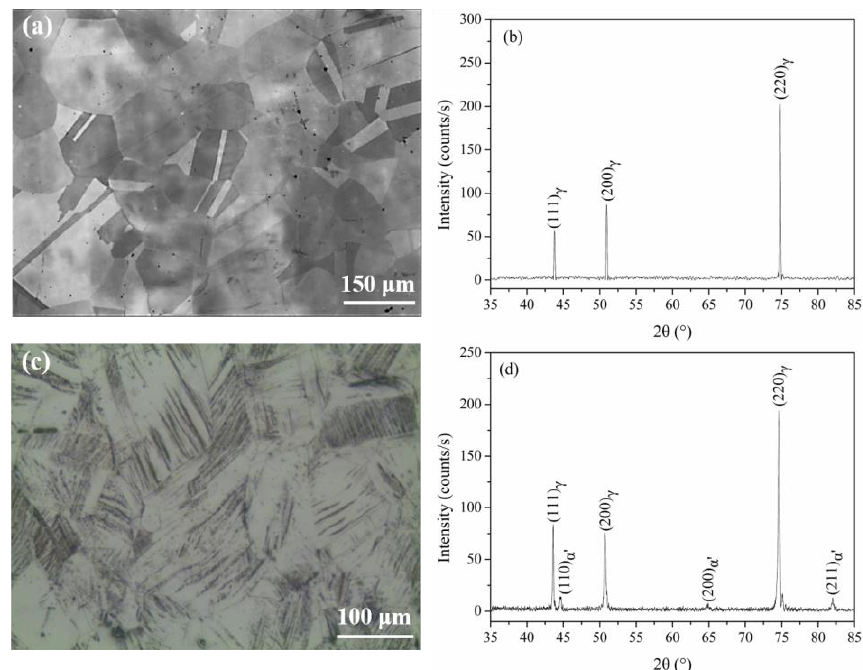
Figure 4. Microstructures of the solution-treated specimen and the one subjected to two thermomechanical cycles: ( a ) light microscope (LM) image and ( b ) X-ray diffraction (XRD) pattern of solution-treated specimen; ( c ) LM image and ( d ) XRD pattern of that after two thermomechanical cycles.